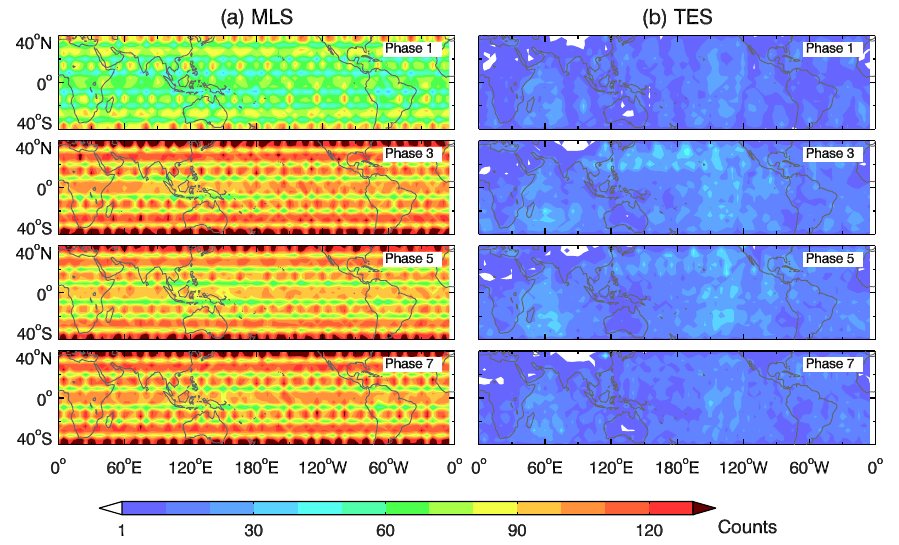
Fig. 2. Number of MLS/TES soundings in each MJO phase during the observational periods of interest. The patterns of MLS statistics in Panel (a) appear to be discretized in space because the MLS profiles are retrieved every 165 km along the sub-orbital track, which is approximately 1.5 ◦ latitude in the equatorial region.